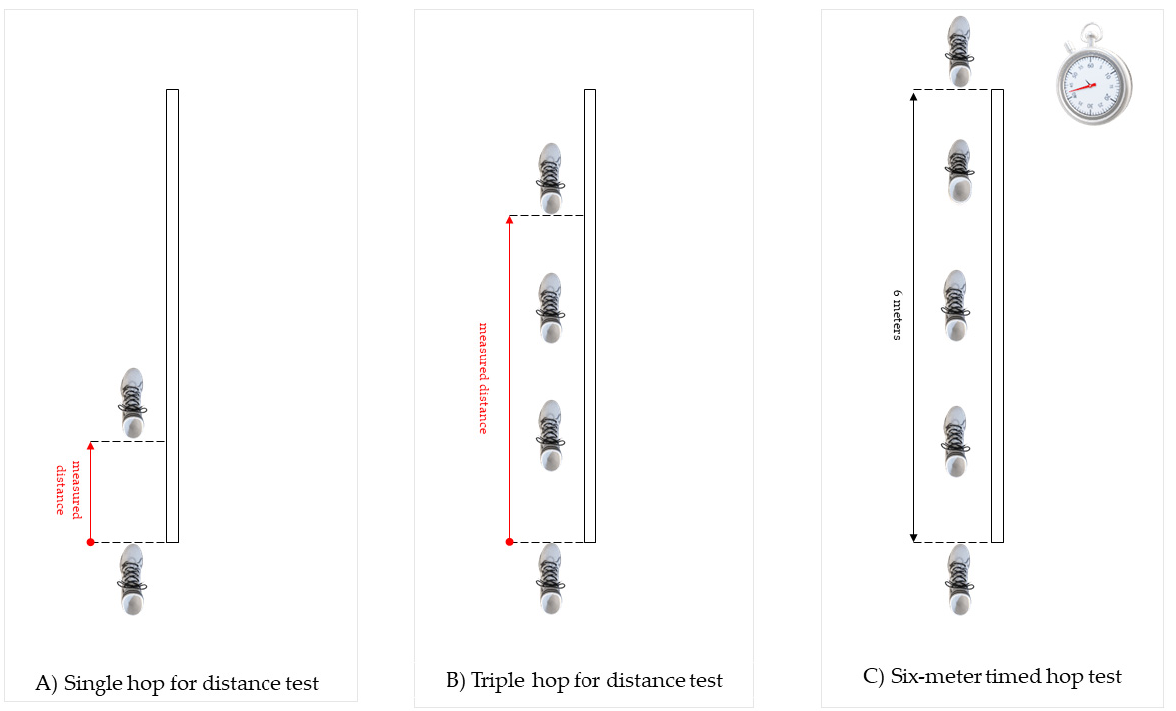
Figure 1. Schematic diagram of the performed battery of three single-leg hop tests, including, consecutively.